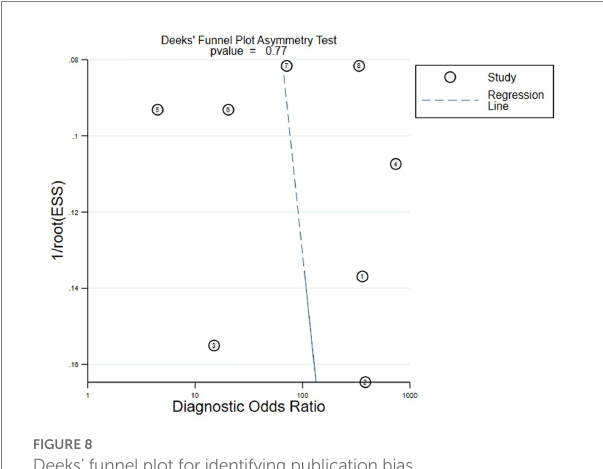
FIGURE 8 Deeks’ funnel plot for identifying publication